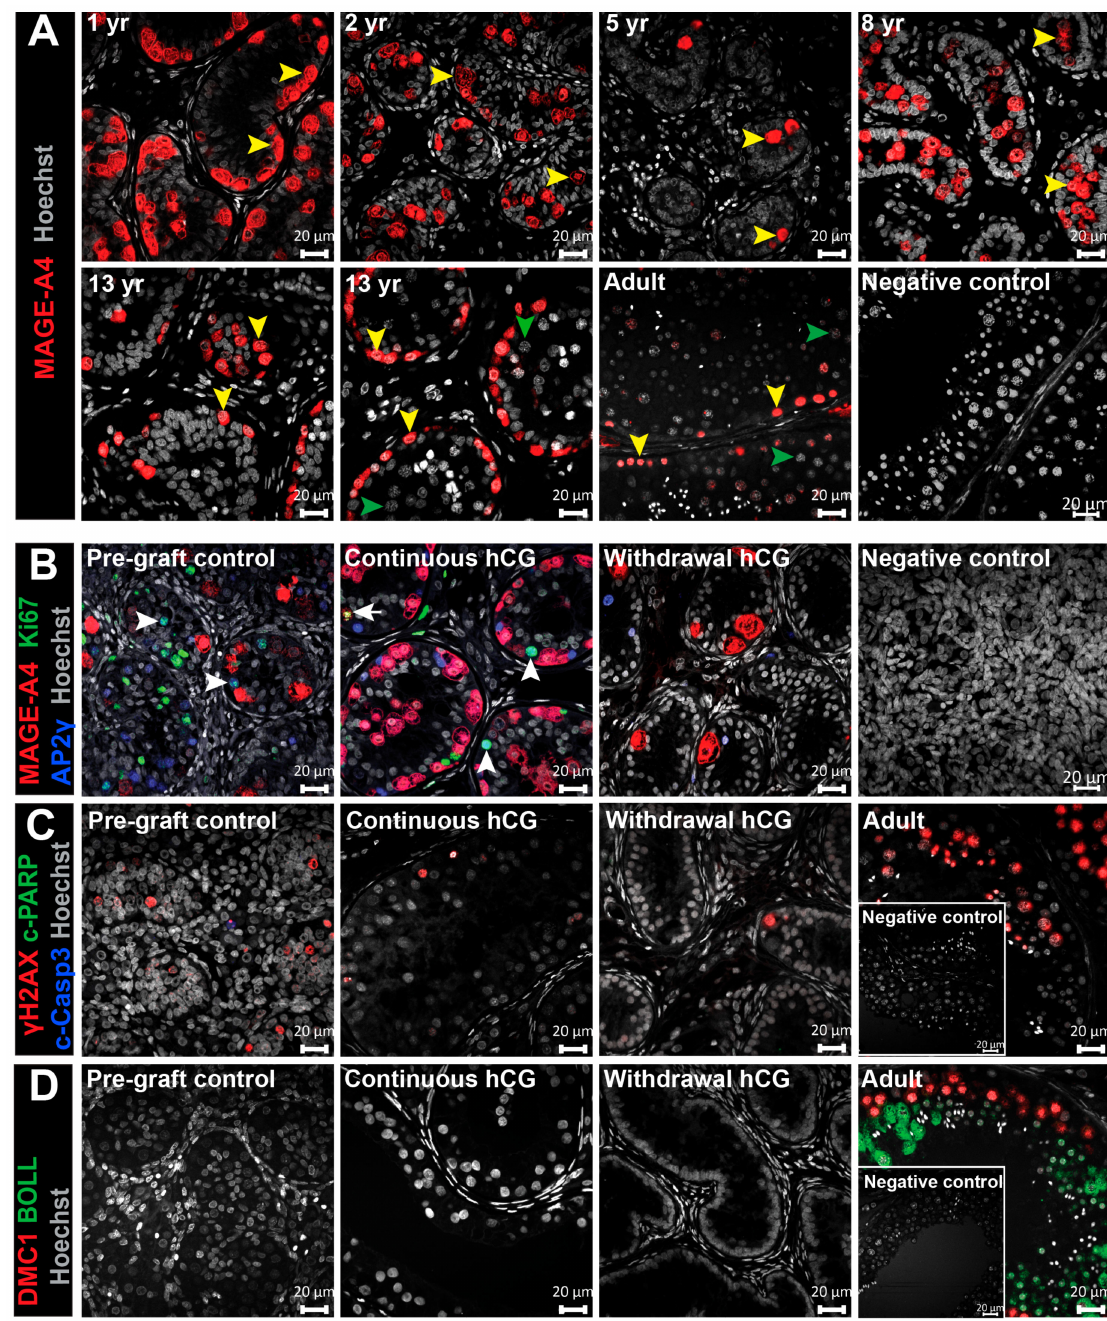
Figure 7. Continuous hCG stimulation supports germ cell survival but does not promote germ cell di ff erentiation in long-term human fetal testis xenografts. ( A ) The distribution of MAGE-A4 + cells (spermatogonia marker) across human testis development. The negative control (adult human testis). The yellow arrowheads indicate spermatogonia. The green arrowheads point to meiotic cells. ( B ) Immunofluorescent analysis of MAGE-A4 (spermatogonia marker), AP2 γ (gonocyte marker), and Ki67 (proliferation marker) expression. Spermatogonia and gonocytes were observed in both the pre-graft control testis tissue and in continuously hCG-treated xenografts (12 months hCG) and the ‘Withdrawal hCG’ group (7 months hCG followed by 5 months withdrawal hCG). The negative control (second-trimester human fetal testis). The white arrowheads denote AP2 γ + / Ki67 + cells. The arrow points to a proliferating MAGE-A4 + / Ki67 + cell. ( C ) Immunofluorescent analysis of γ H2AX (meiotic- and apoptotic marker), c-PARP (apoptotic marker), and c-Casp3 (apoptotic marker)